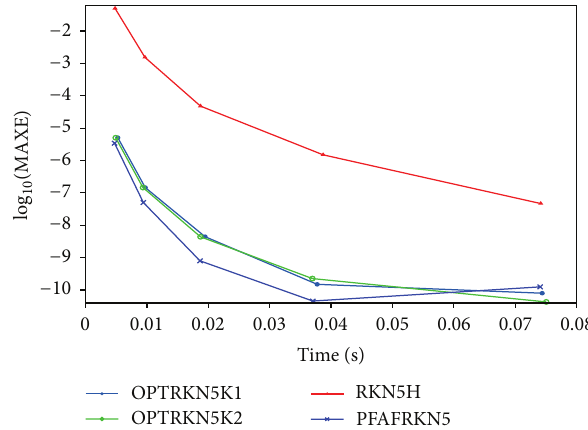
Figure 12: Efficiency curves for all methods for Problem 1 with 𝑒 = 0.3 and ℎ = 1/2 𝑖 , 𝑖 = 3,...,7 .